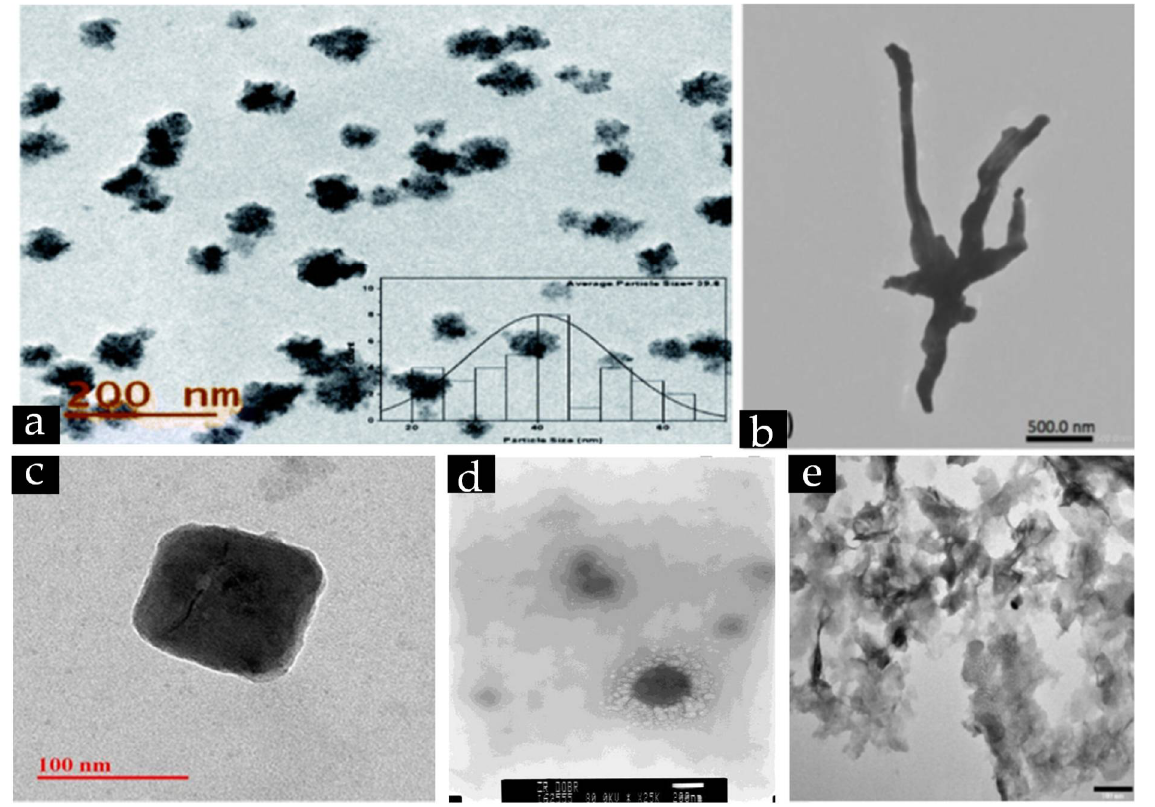
Figure 3. Representative TEM images of ( a ) spherical CuO nanoparticles synthesised using Annona squamosa seed extract. Reproduced from [204]. 2021with permission from the Royal Society of Chemistry, ( b ) tentacle-like bimetallic Ag-Cu nanoparticles synthesised using Carica papaya extract. Adapted with permission from Ref. [172]. 2017, Elsevier, ( c ) cubical Cu nanoparticles synthesised from Azadirachta indica leaf extract Adapted with permission from Ref. [65]. 2018, Elsevier; ( d ) SEM image of spherical Cu-Pt core shell nanoparticles synthesised using Agrimoniae herba extract. Adapted with permission from Ref. [170]. 2018, Elsevier; and ( e ) TEM image of Cu-Co-Ni trimetallic nanoalloy nanoflakes synthesised using Origanum vulgare leaf extract. Adapted with permission from Ref. [176]. 2020, MDPI.